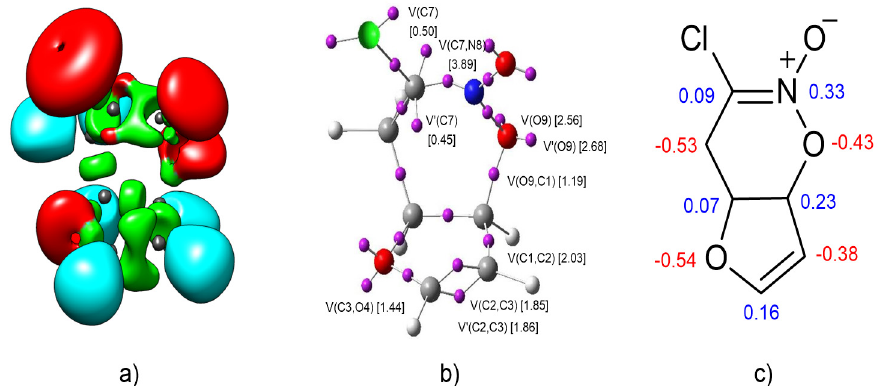
Figure 1. ( a ) ELF localization domains of 1 , represented at an isosurface value of the Electron Localization Function (ELF) = 0.75; ( b ) ELF basin attractor positions, together with the most representative valence basin populations; ( c ) Lewis-like structure of 1 together with the natural atomic charges, obtained through an Natural Population Analysis (NPA). Negative charges are colored in red, and positive charges are colored in blue. ELF valence basin population and natural atomic charges are given in average number of electrons, e.